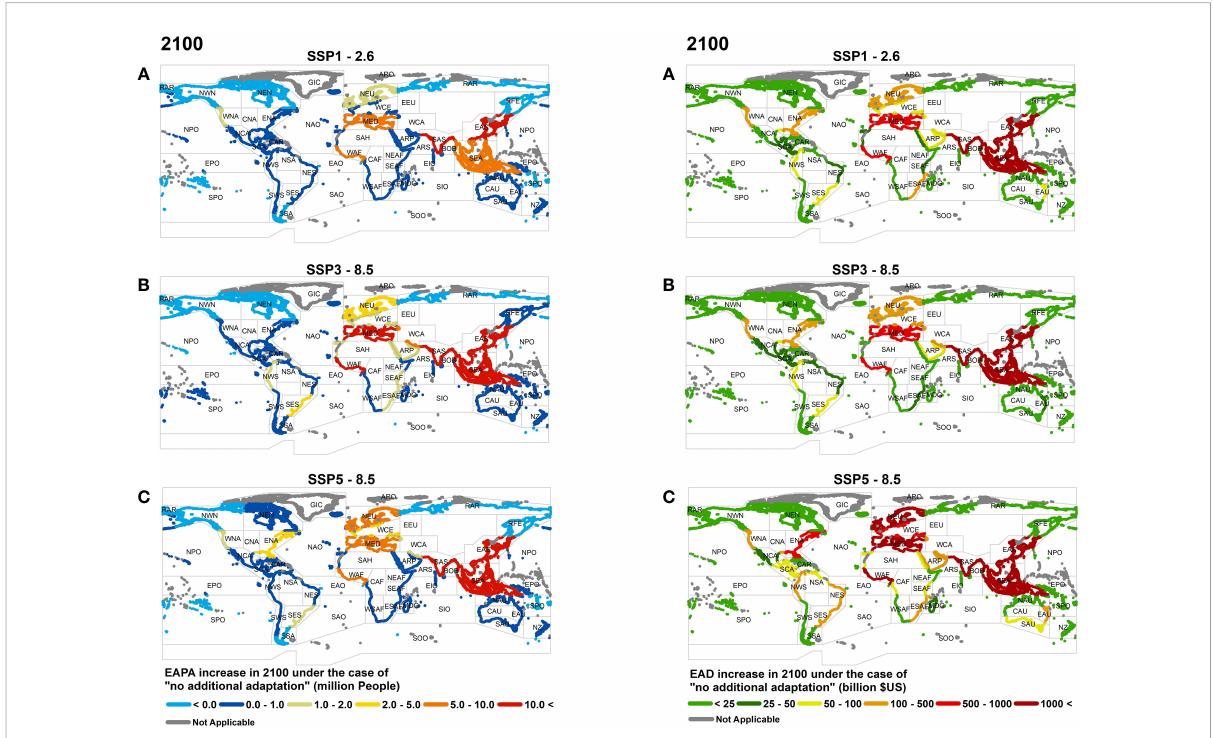
FIGURE 4 Changes in EAPA (left panels) and EAD (right panels) in 2100 for the scenario of no additional adaptation , where there are no changes in adaptation measures from present-day and fl ooding probability increases with time. Values shown represent the change relative to 2015. Panels show different RCP/SSP narratives (A) SSP1-2.6, (B) SSP3-8.5, (C)